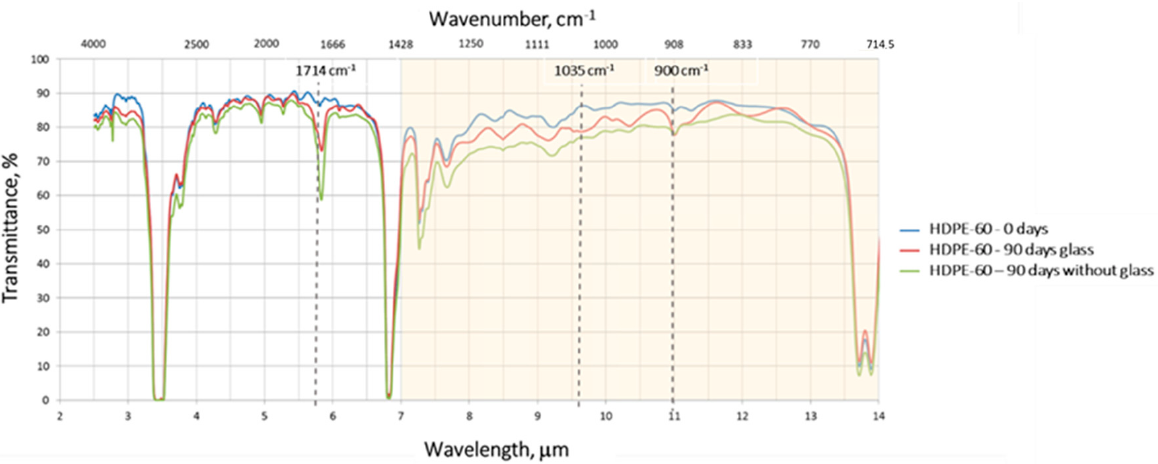
Figure 10. HDPE-60 FT-IR spectra in transmission mode.